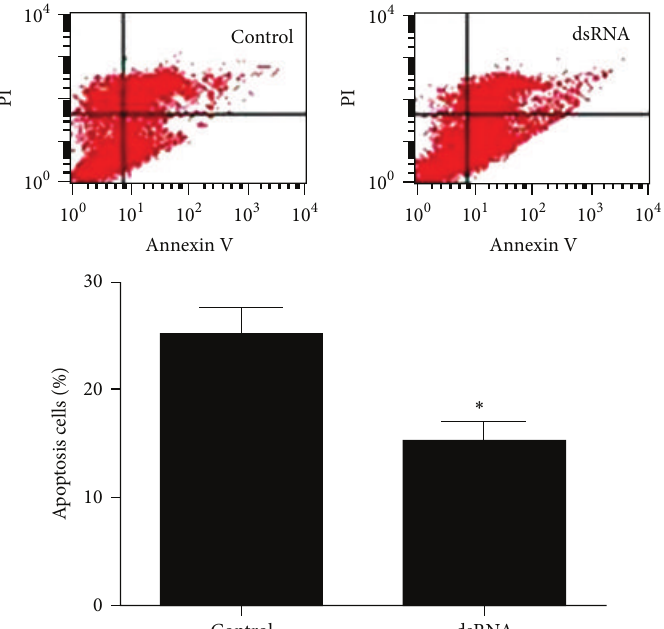
Figure 6: Flow cytometry detection of apoptosis. dsRNA induced HepG2.2.15 cell apoptosis ( ∗ 𝑃 < 0.05 versus control